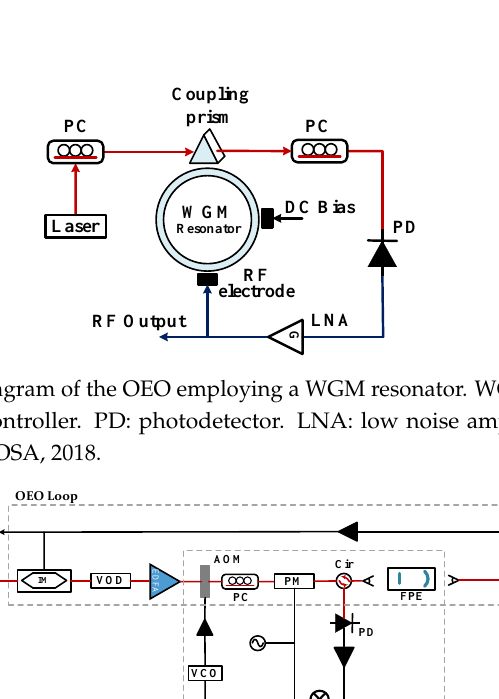
PC Injection source Figure 7. The schematic diagram of the injection-locked OEO. PD: photodetector. PS: phase shifter. PC: power coupler. HPF: high-pass filter. Reprinted with permission from Ref. [40], OSA, 2018 . Laser MZM Laser Figure 8. The schematic diagram of the dual-injection-locked OEO. Reprinted with permission from Ref. [41], OSA, 2018 . High-Q microwave photonic filters such as whispering gallery mode (WGM, Figure 9) resonator [26], Fabry-Perot etalon [35], and atomic cells [42] can simultaneously implement energy storage and frequency selection for OEOs, replacing the conventional long fiber and microwave filter. In [43], M. Bagnell et al. utilized a Fabry – Perot etalon with a finesse of 100,000 as a photonic filter in a conventional single loop OEO as shown in Figure 10. The etalon provided a high Q-value microwave band-pass filtering at harmonics of 1.5 GHz free spectral range for oscillation frequency in the range